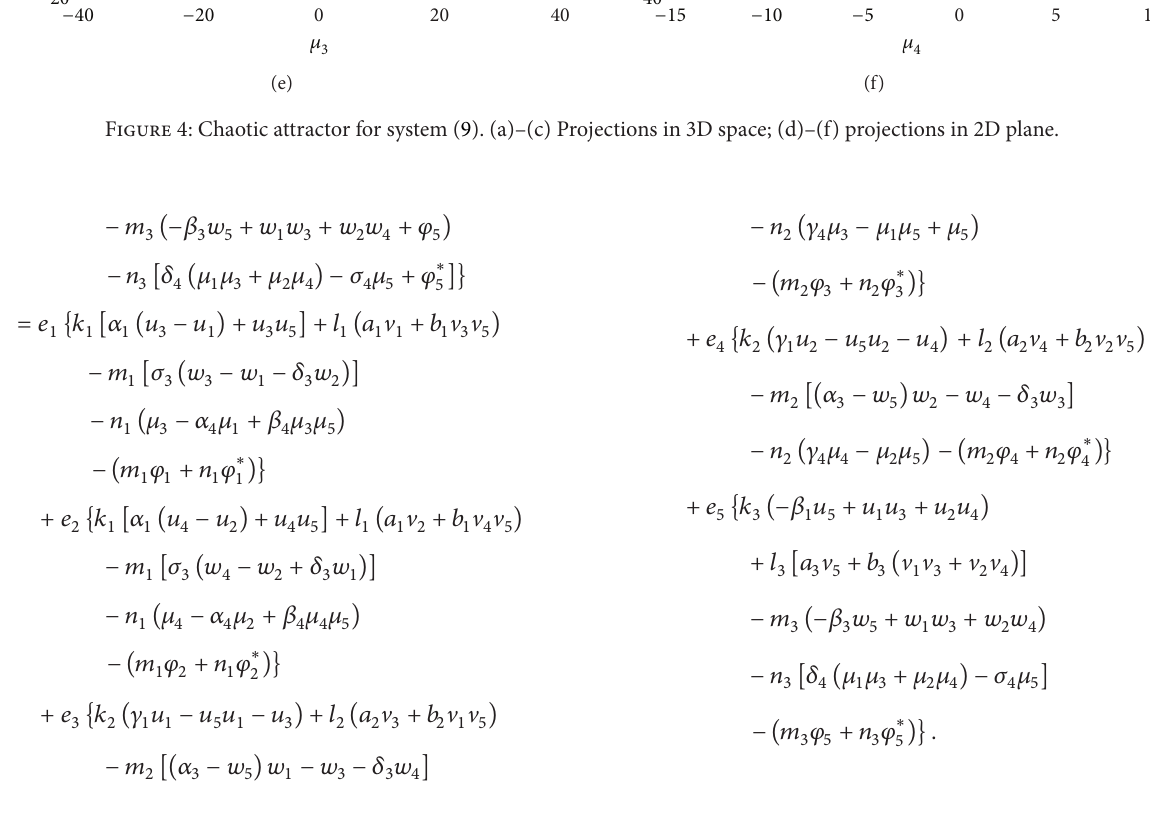
Figure 4: Chaotic attractor for system (9). (a)–(c) Projections in 3D space; (d)–(f) projections in 2D plane.